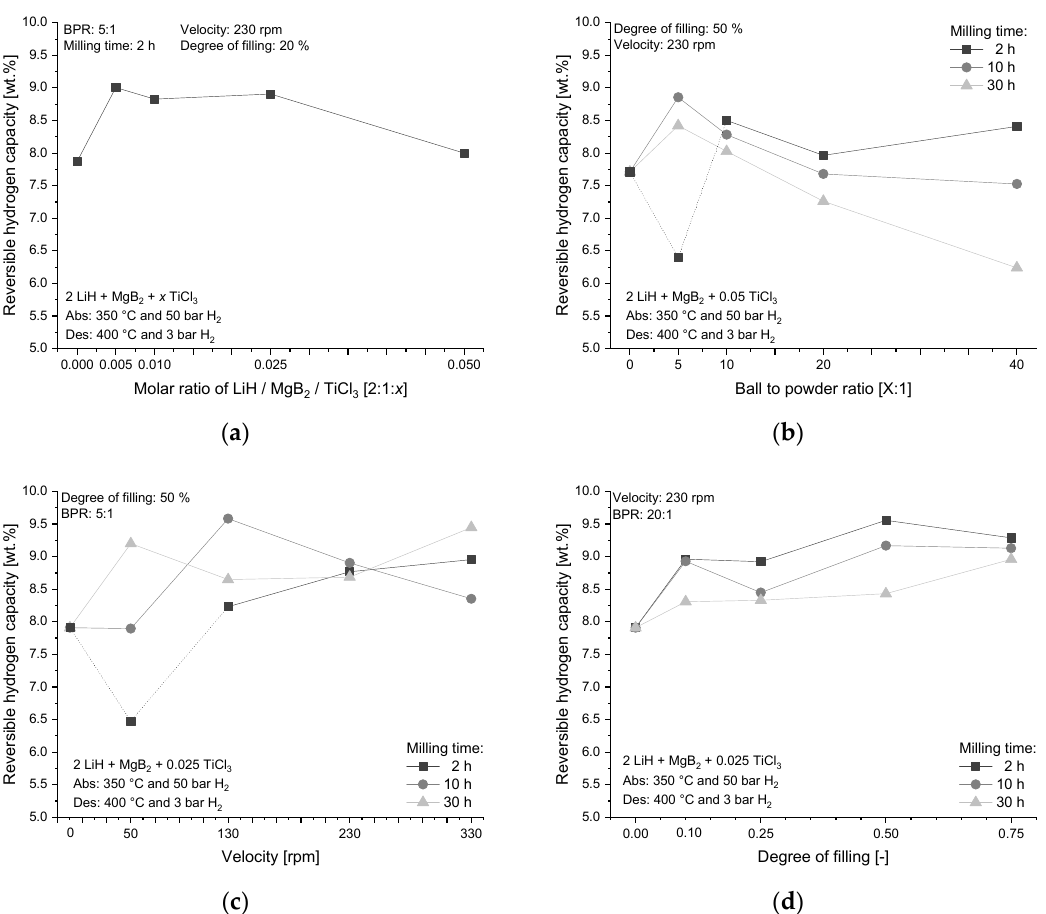
Figure 3. Reversible capacity of hydrogen after desorption as function of ( a ) amount of additive, ( b ) BPR, ( c ) milling velocity, and ( d ) degree of filling. Some sets display different milling times, too.